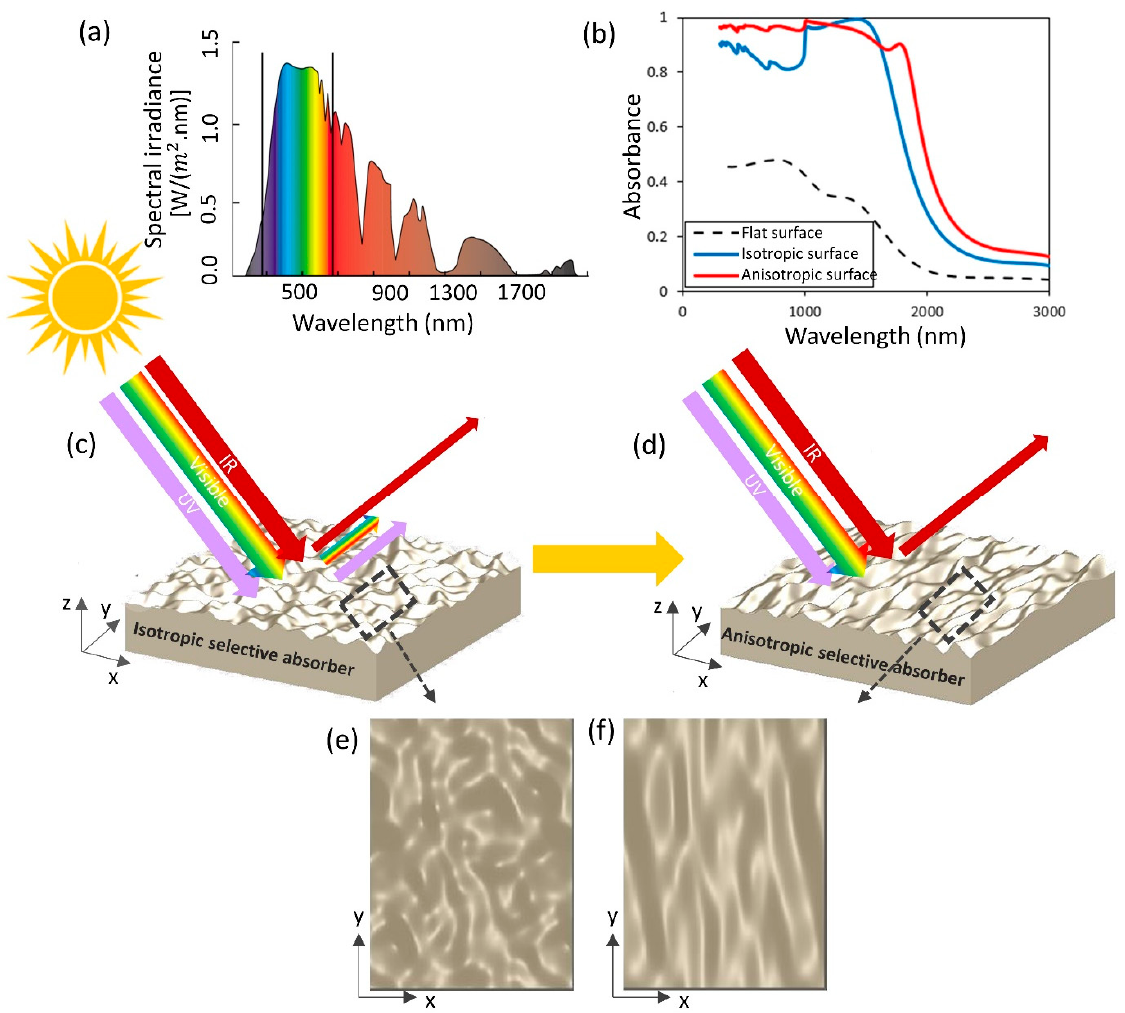
Figure 1. Schematic of proposed selective absorber; ( a ) solar radiation spectrum; ( b ) comparison of absorption spectrum for flat surface and rough surface; ( c ) scattering from isotropic random rough surface; ( d ) scattering from anisotropic random rough surfaces; ( e ) top view of isotropic rough surface; ( f ) top view of anisotropic rough surface.